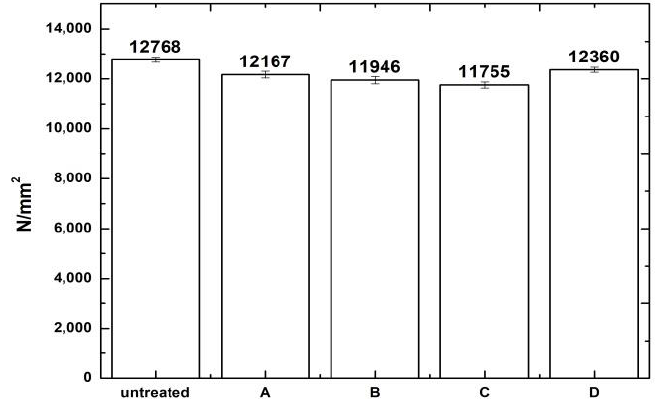
Figure 4. MOE of untreated and PF resin-treated beech wood samples. (A) M w values of 237 g/mol, (B) M w values of 305 g/mol, (C) M w values of 403 g/mol, (D) M w values of 520 g/mol.